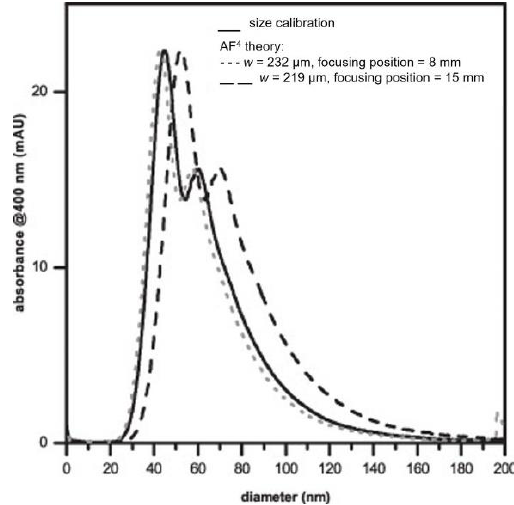
Figure 2. Size distributions of AgNPs by two different approaches: (i) size calibration using polystyrene beads (PSNPs) and (ii) conversion of retention times on AF4 analysis to diameters by AF4 theoretical calculations. Reprinted from [27] copyright (2013), with permission from Elsevier.